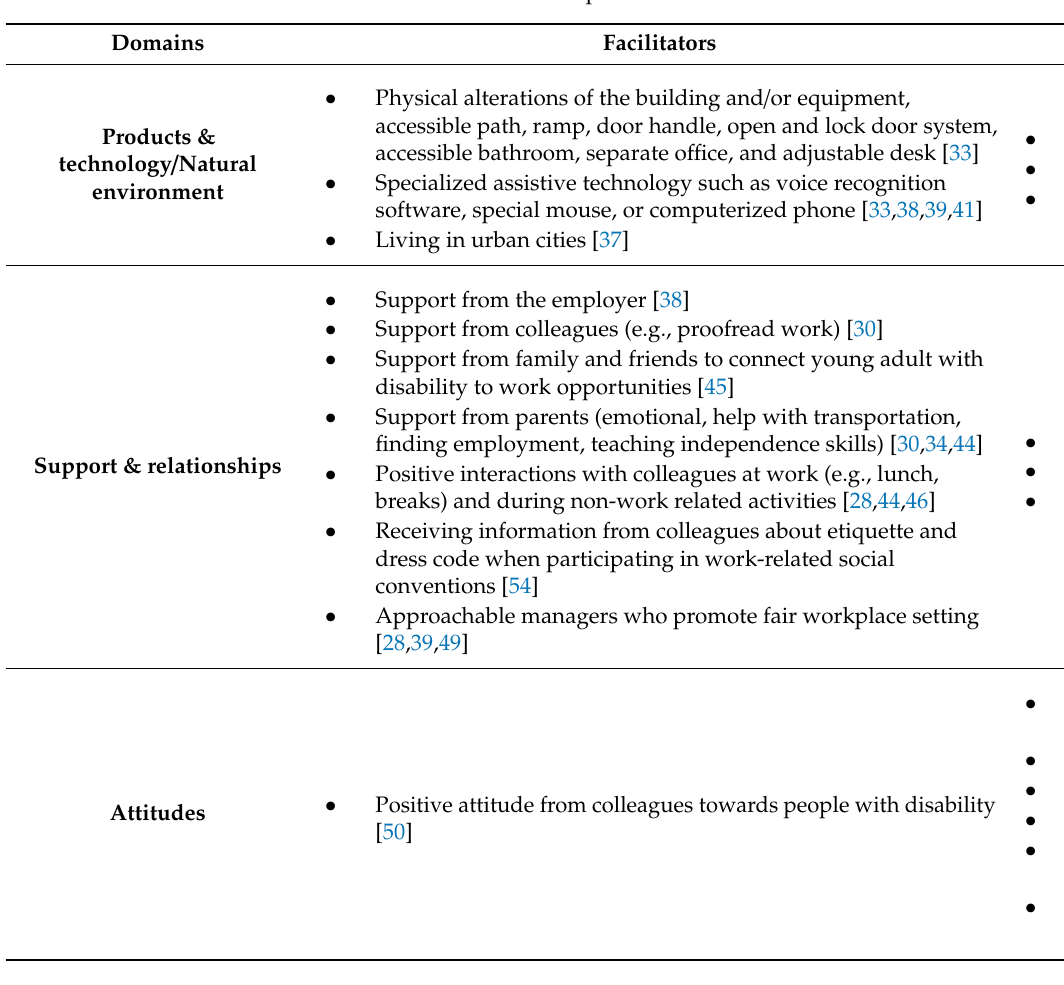
Table 3. Examples of environmental barriers and facilitators across the ICF